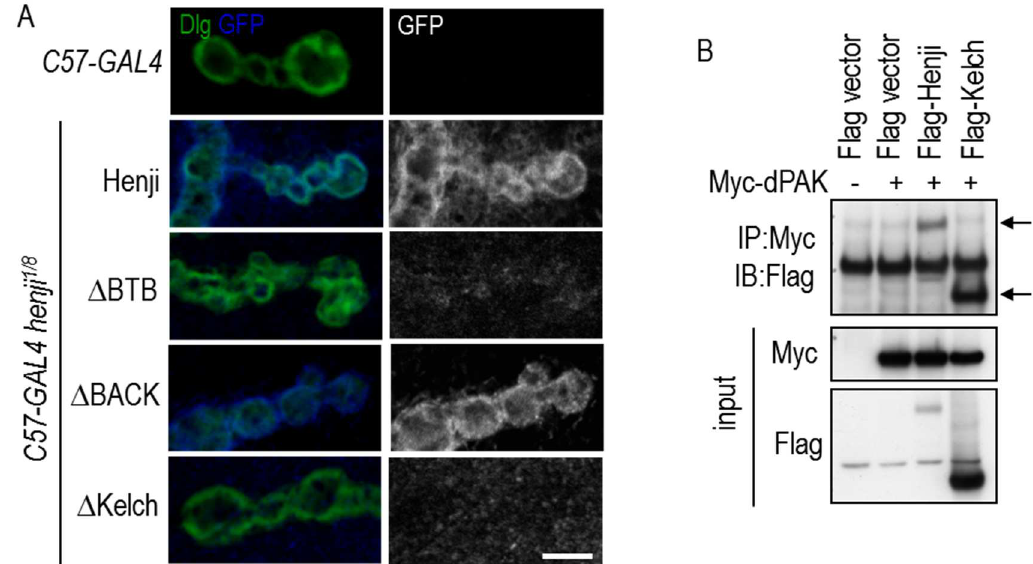
for Dlg and GFP. Scale bar is 5 μ m. (B) Immunoprecipitation of Myc-dPAK complexes (IP) from transfected S2 cells were assayed for the presence of Flag-taggedfull-lengthHenji and the Kelch repeats domain(indicatedby arrows) by Western blot (IB). Inputs of dPAK and Henji proteins are at bottom two